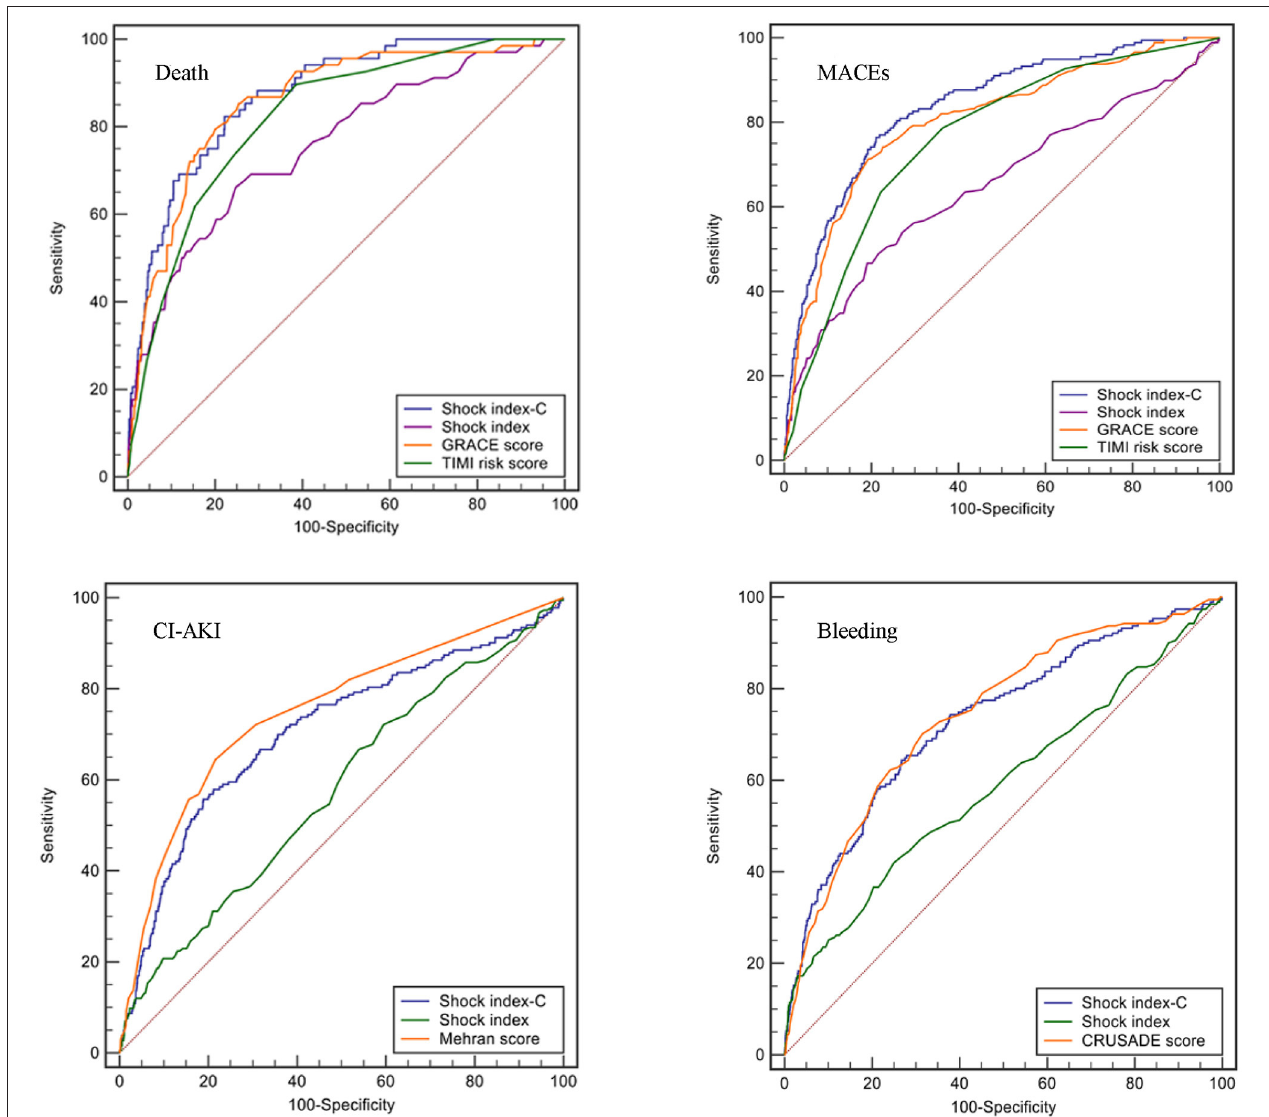
FIGURE 4 | ROC curves of different scores for in-hospital events (death, MACEs, CI-AKI, and bleeding) in the overall population.